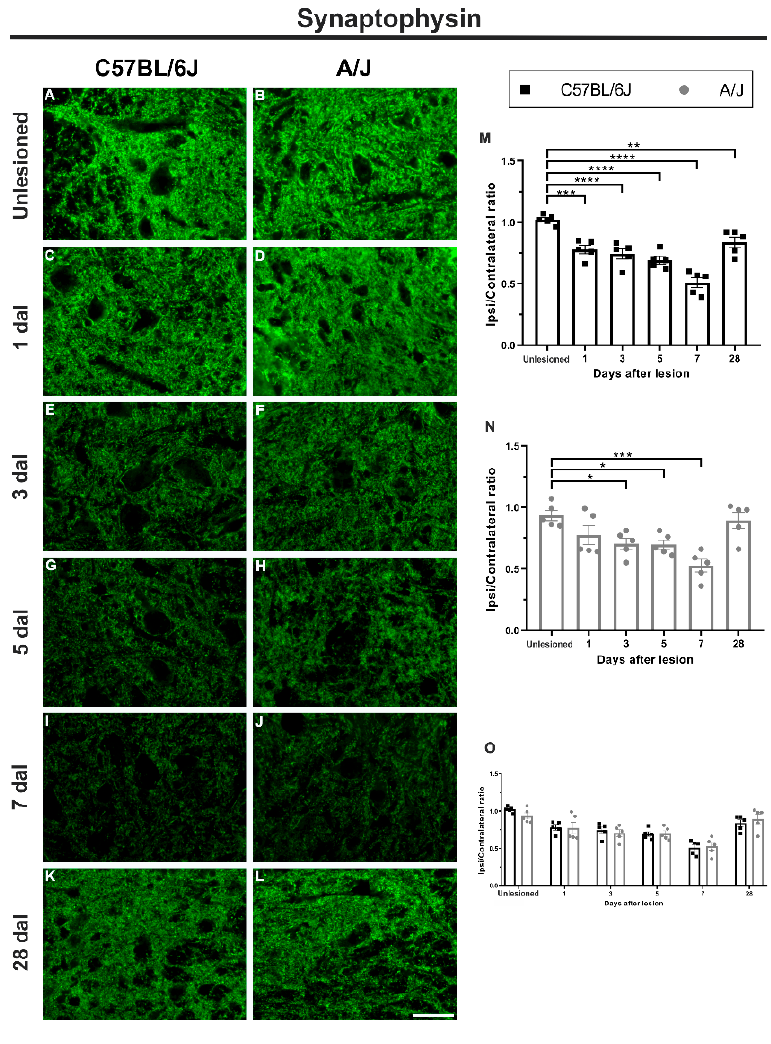
Figure 3. Synaptophysin immunostaining (presynaptic marker) decreased over time, with the lowest value 7 days after sciatic nerve crush in the C57BL/6J and A/J strains. ( A – L ) Representative images of lamina IX of Rexed in control animals and in the groups that received peripheral nerve crush 1, 3, 5, 7, and 28 days after lesion, both ipsilateral and contralateral to injury. ( M ) Synaptic reactivity in C57BL/6J animals, with a progressive decrease in synaptophysin labeling from 1 to 7 days after lesion (dal), at which the lowest value was reached. After 28 d, synaptophysin expression improved, but was still lower than that found in the control group. ( N ) Synaptic labeling in A/J mice, with a progressive decrease in the labeling for synaptophysin 3 to 7 dal, reaching the lowest value. Note that at 28 dal, synaptophysin expression improved, corresponding to the value found in the control group. ( O ) Comparison between the values found in the C57BL/6J and A/J strains on the different days after peripheral nerve injury, with no significant difference between the strains. Quantification of the integrated density of pixels was carried out on the surface of the motoneurons (ipsilateral/contralateral ratio, n = 5 per group/dal). Mean ± SEM; * p < 0.05; ** p < 0.01; *** p < 0.001; **** p < 0.0001. Scale bar: 50 µ